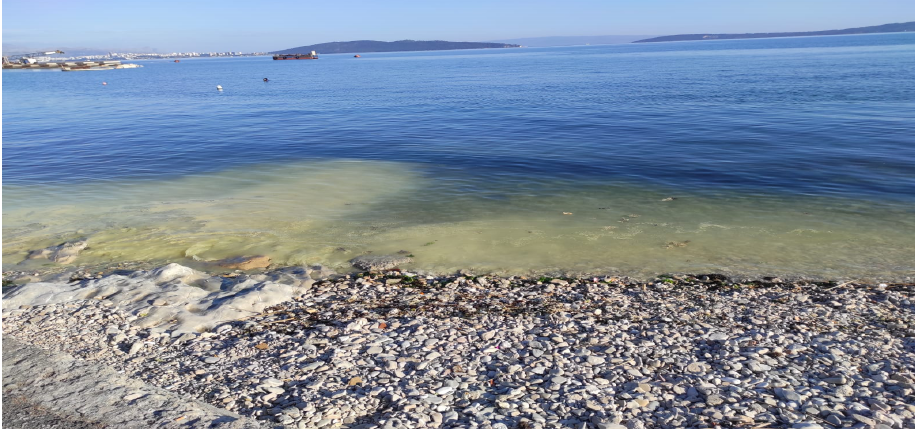
Figure 8. Algae Blooms in Kaštela Bay on 1 April 2021.